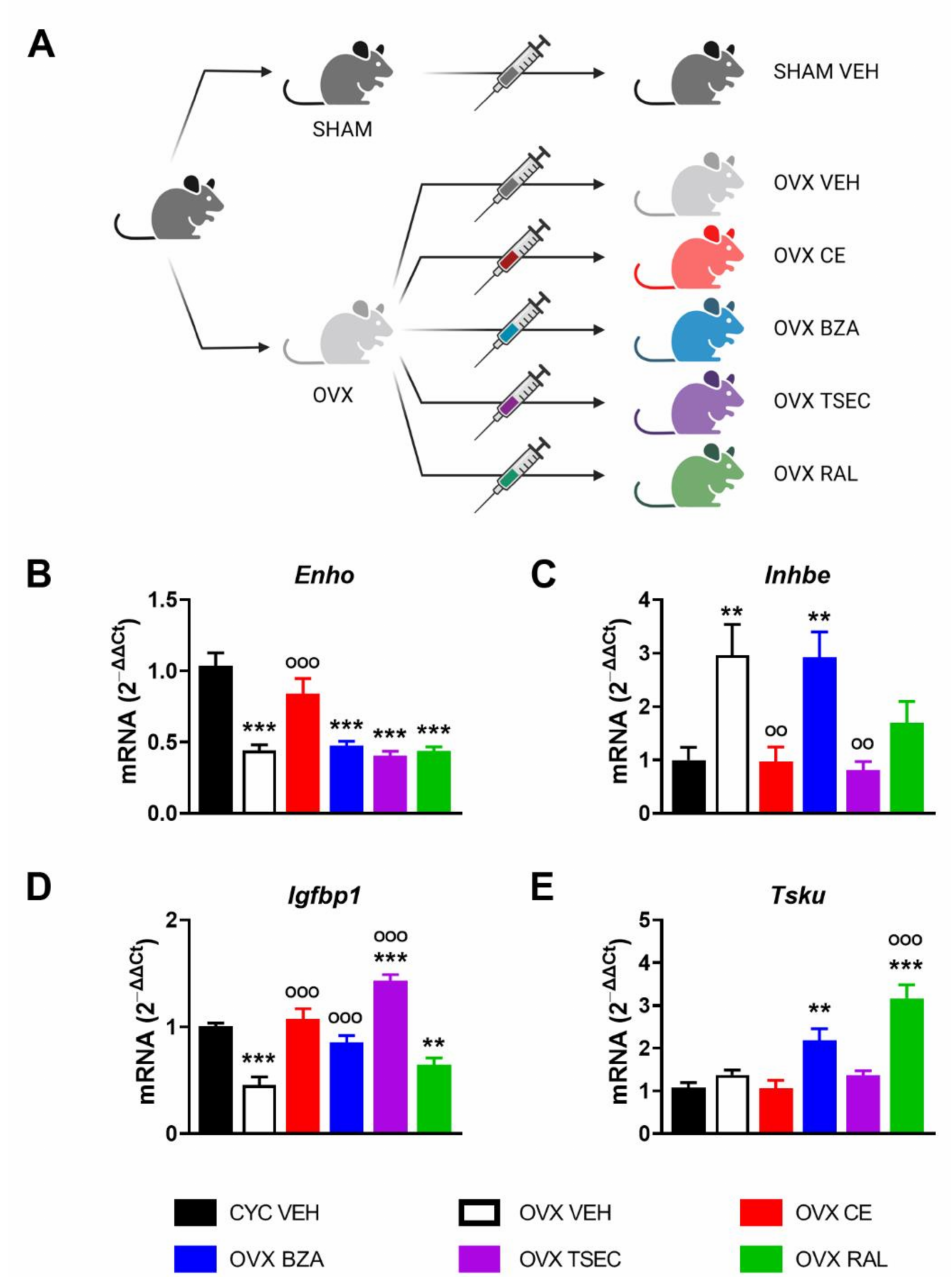
Figure 3. Estrogen-based hormone replacement therapy (HRT) modulates hepatokine mRNA levels in ovariectomized (OVX) female mice. ( A ) Experimental design adopted to evaluate the effects of several HRTs in OVX female mice. ( B – E ) mRNA content of Enho ( B ), Inhbe ( C ), Igfbp1 ( D ), and Tsku ( E ) measured by RT-PCR in the liver of cycling fertile (CYC) and OVX female mice treated with vehicle (VEH), conjugated estrogen (CE), bazedoxifen (BZA), BZA plus CE (TSEC), or raloxifen (RAL) for 21 days. Data are presented as mean ± SEM ( n = 8–10). ** p < 0.01 and *** p < 0.001 vs. CYC; ◦◦ p < 0.01 and ◦◦◦ p < 0.001 vs. OVX by one-way ANOVA followed by Bonferroni’s post hoc